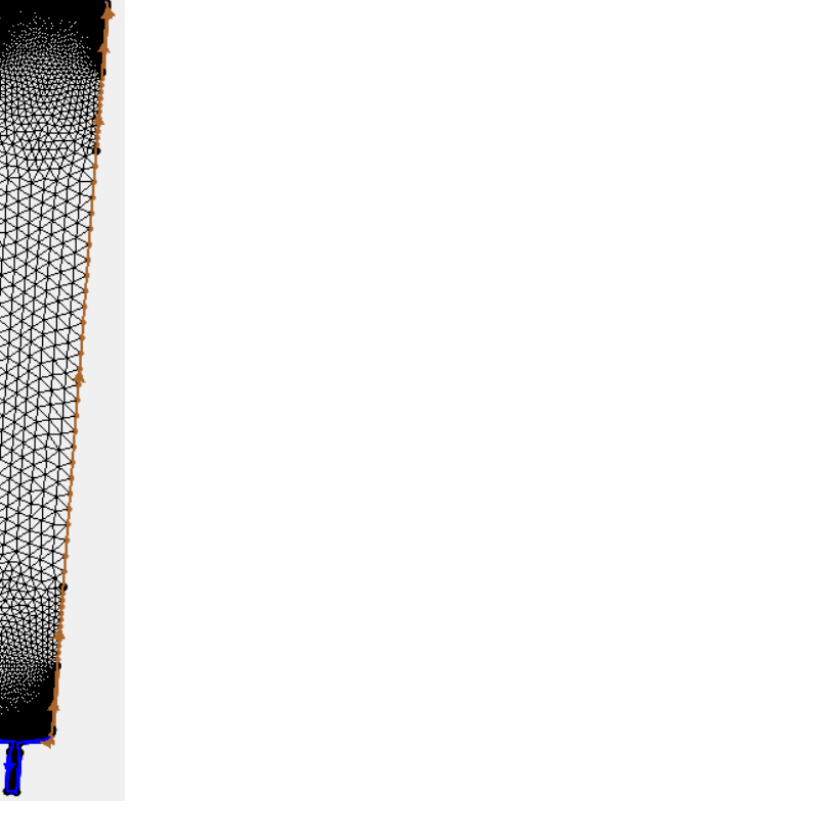
Figure 3. Schematic of grid partition of channel #1 in sedimentation basin.